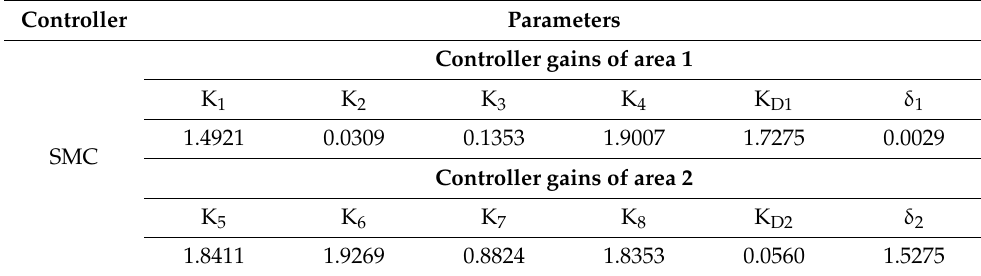
Table 3. The optimum SMC gains obtained by BA.